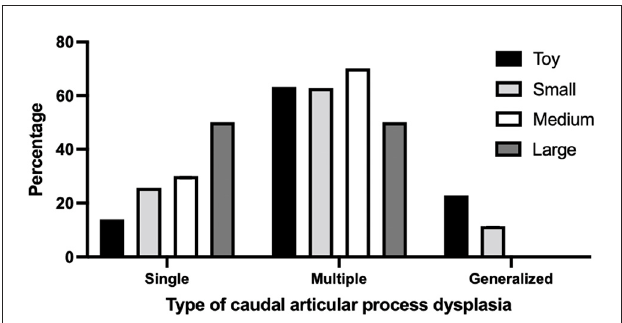
FIGURE2 Percentage of type of caudal articular process dysplasia between breeds classified by weight. The number of affected vertebrae was divided into the following CAP dysplasia types: Single, affected only one vertebra; Multiple, affected 2–6 vertebrae; Generalized, affected vertebrae > 6. Breeds were classified by weight: (i) toy breeds, < 5kg; (ii) small breeds; 10kg; (iii) medium breeds; 10–25kg, (iv) large breeds, >